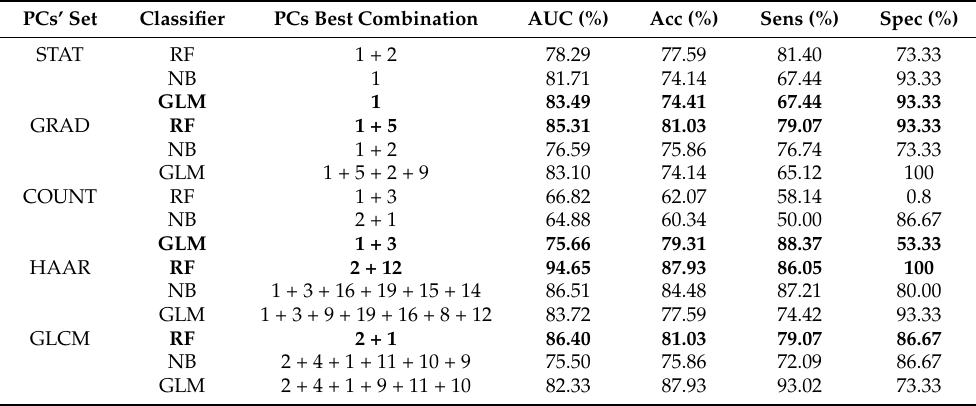
Table 1. Classification performances of the best models obtained from the individual PCs’ sets calculated on 100 ten-fold cross-validation rounds. For each set of features, the performance measures of the different classification algorithms implemented are reported in correspondence with the best PC combination. The third column shows the PCs selected by the sequential forward selection algorithm. The best results are highlighted in bold.